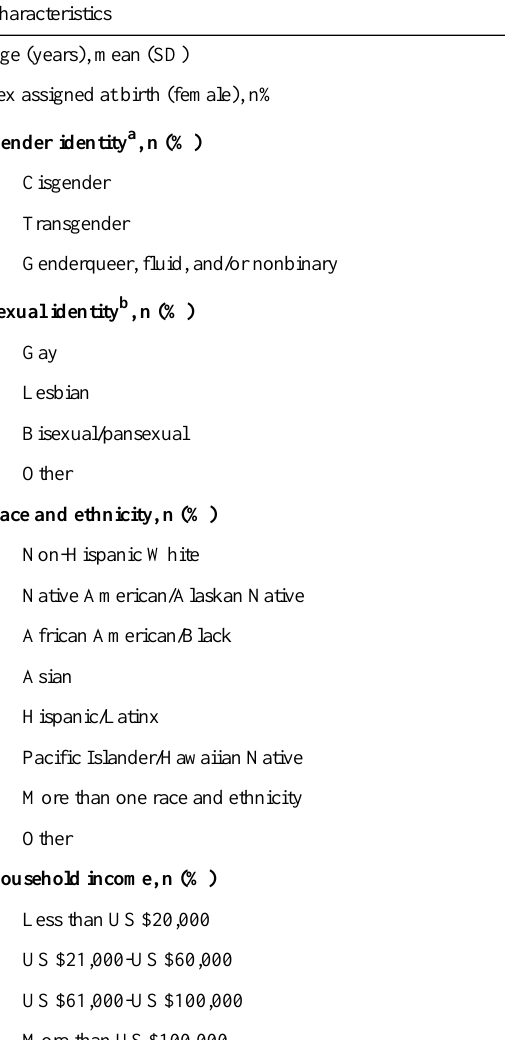
Table 1. Participant characteristics (N=302).